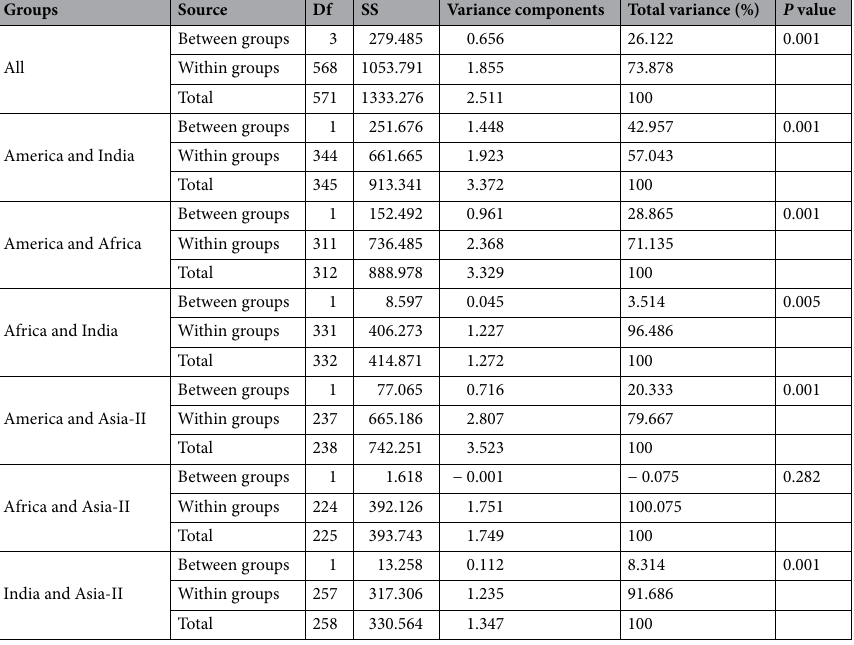
Table 3. Results of AMOVA analysis among the four FAW geographical